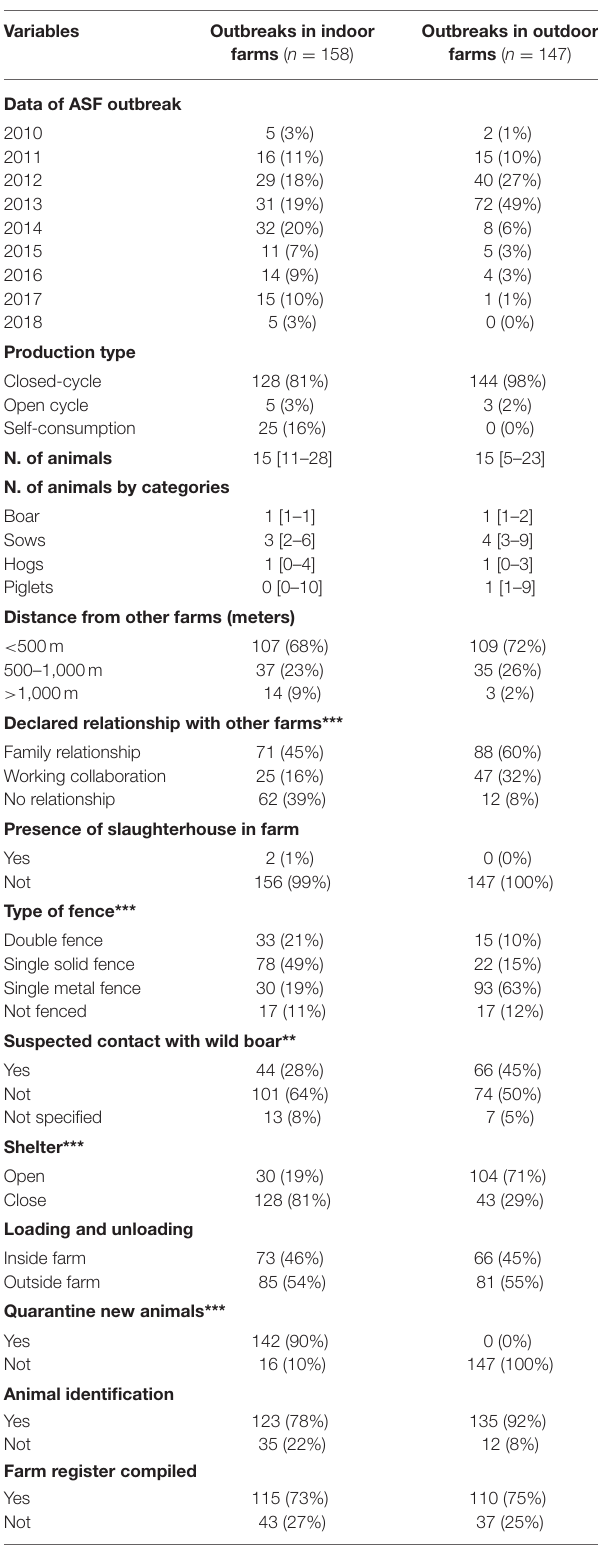
TABLE 1 | Baseline descriptive statistics of the farm features, by farm type (indoor and